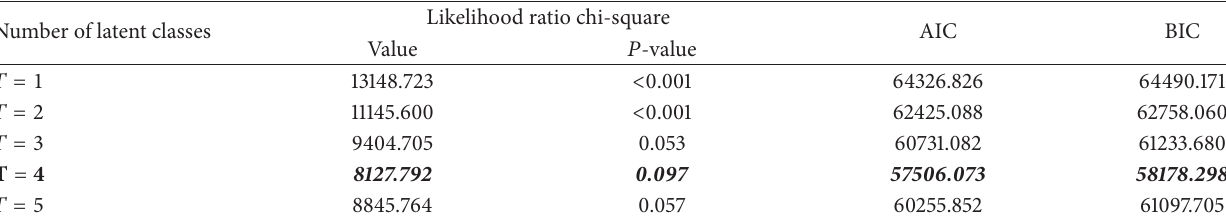
Table 3: Fit criteria of the